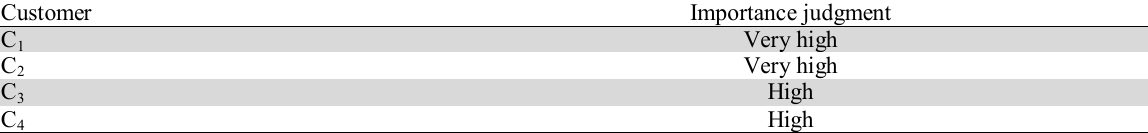
Importance ranking of the firm’s main customers